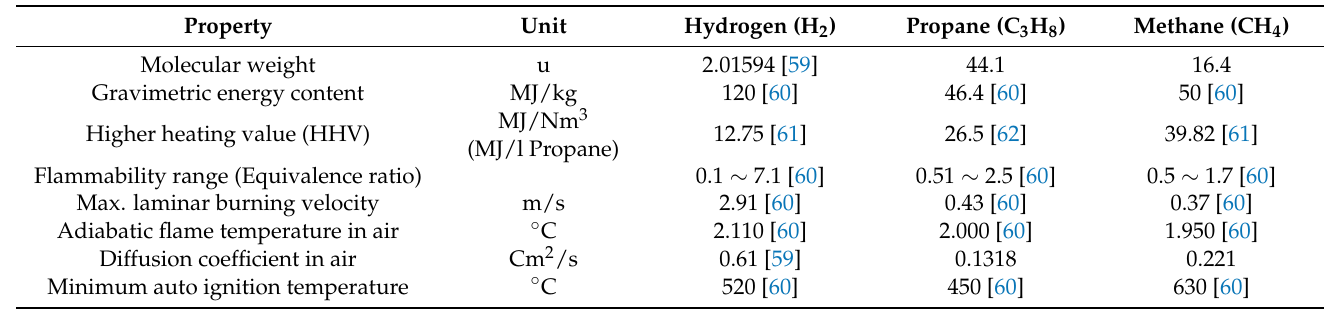
Table 3. Selected properties of hydrogen, propane, and methane. As the main compound of LPG and natural gas, the properties of propane and methane approximate LPG and natural gas properties, respectively.